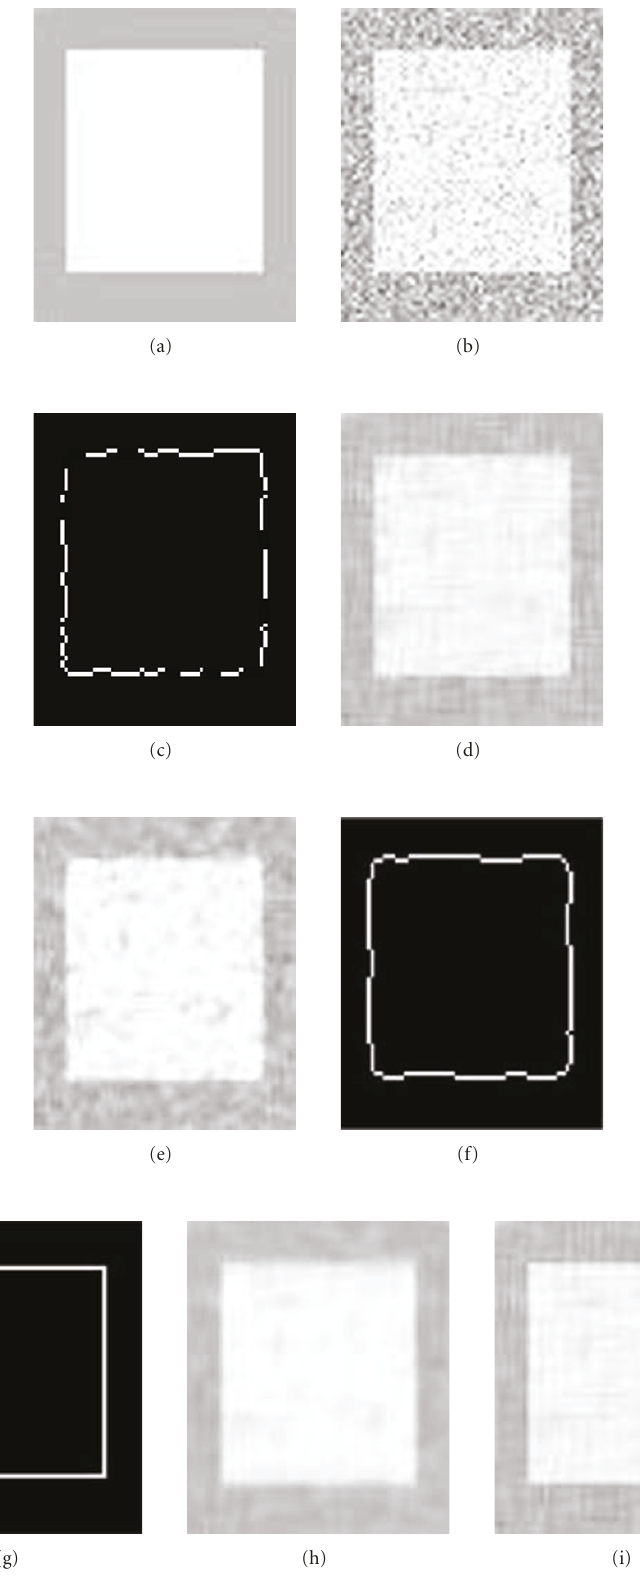
Figure 12: (a) Synthetic image, (b) noisy image with Gaussian noise with σ = 0 . 05, (c) edge map obtained from (b), (d) denoised image at final stage, (e) denoised image by neighborhood filters, (f) edge map obtained from (e), (g) modified edge map, (h) denoised image at final stage, and (i) denoised image at final